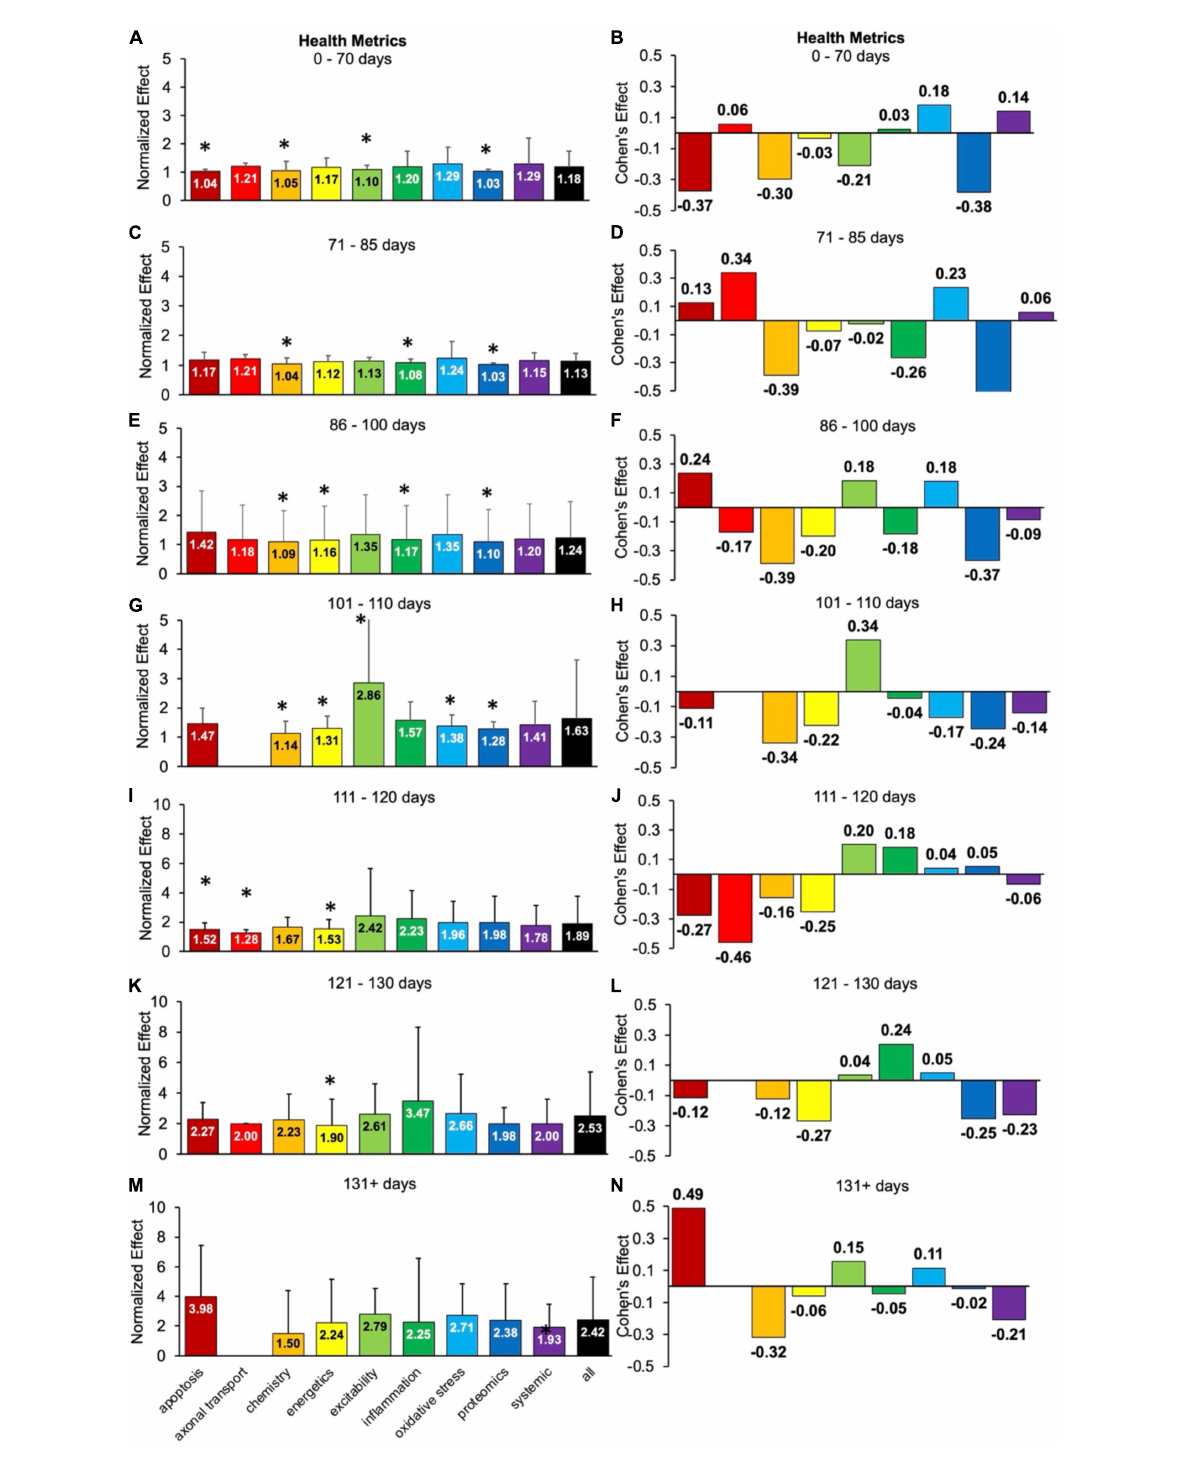
FIGURE4 Health status metrics assessed for each pathophysiological treatment category over time (in post-natal days). Normalized effect size is illustrated on the left. Error bars represent standard deviation. Axonal transport is excluded in a few time bins due to inadequate sample size. For each respective time bin, the pathophysiological treatment category was compared to the overall treated average or “all” (black bar) with ∗ denoting a significant difference ( p < 0.05). Calculated Cohen’s effect size for each pathophysiological treatment category and time bin is illustrated on the right. (A,B) 0- 70 days. (C,D) 71–85 days. (E,F) 86–100 days. (G,H) 101–110 days. (I,J) 111–120 days. (K,L) 121–130 days. (M,N) 131 +